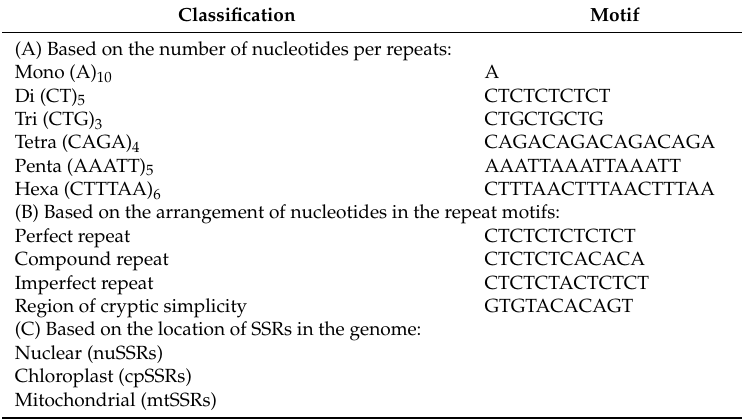
Table 1. Classification of microsatellites (Adapted from Kalia et al. [26]).